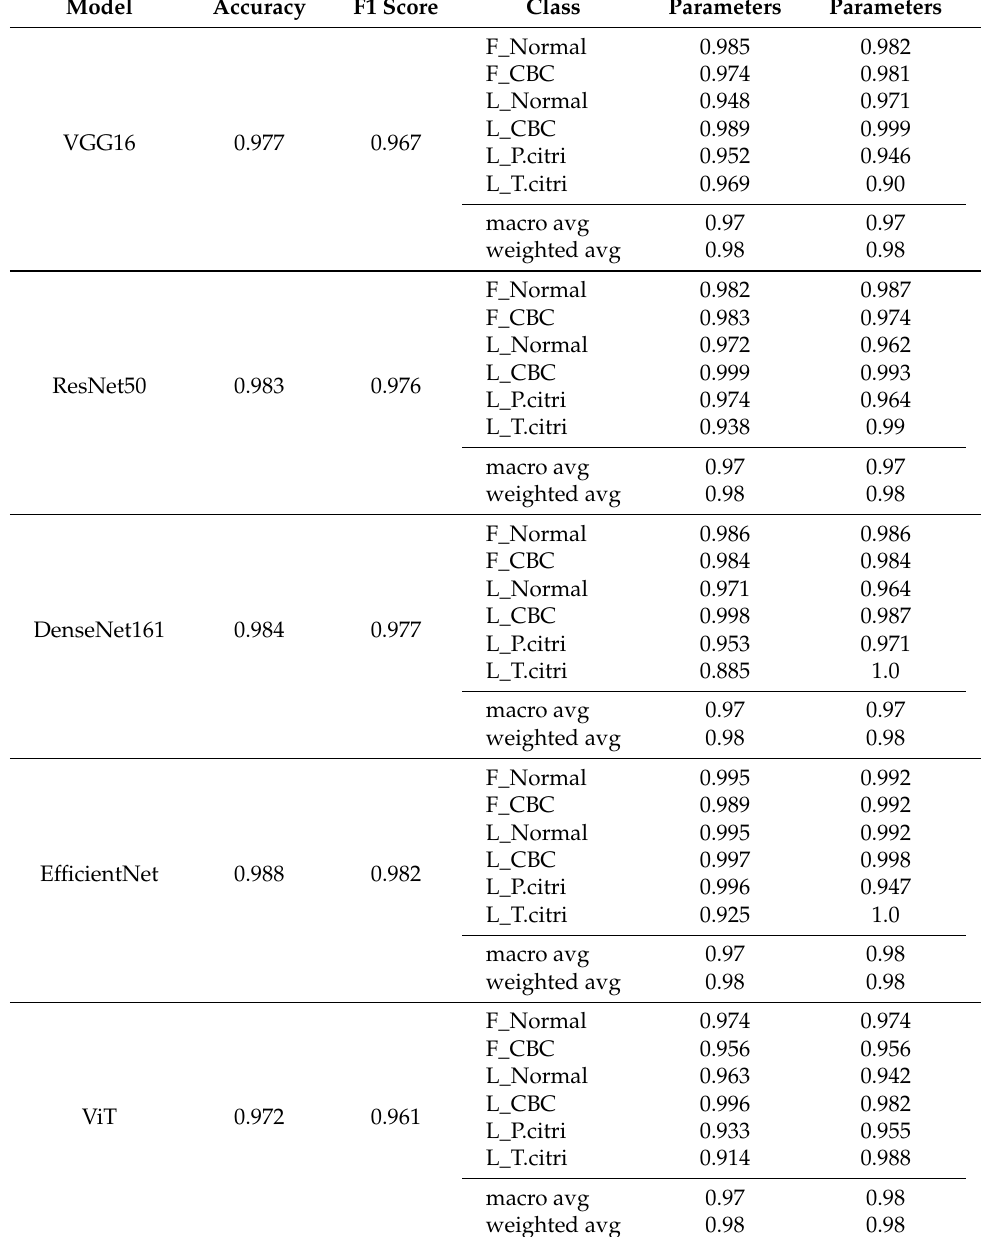
Table 3. Five model validation classification performance of the citrus